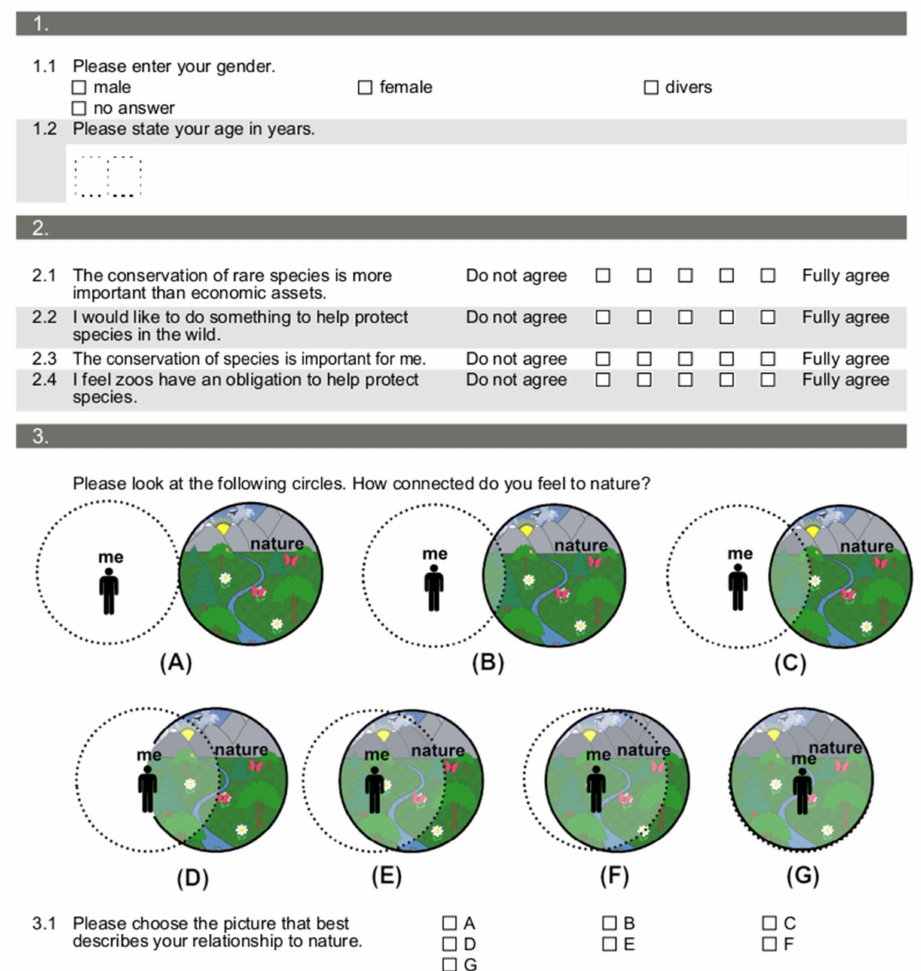
Figure A1. The questionnaire used for the